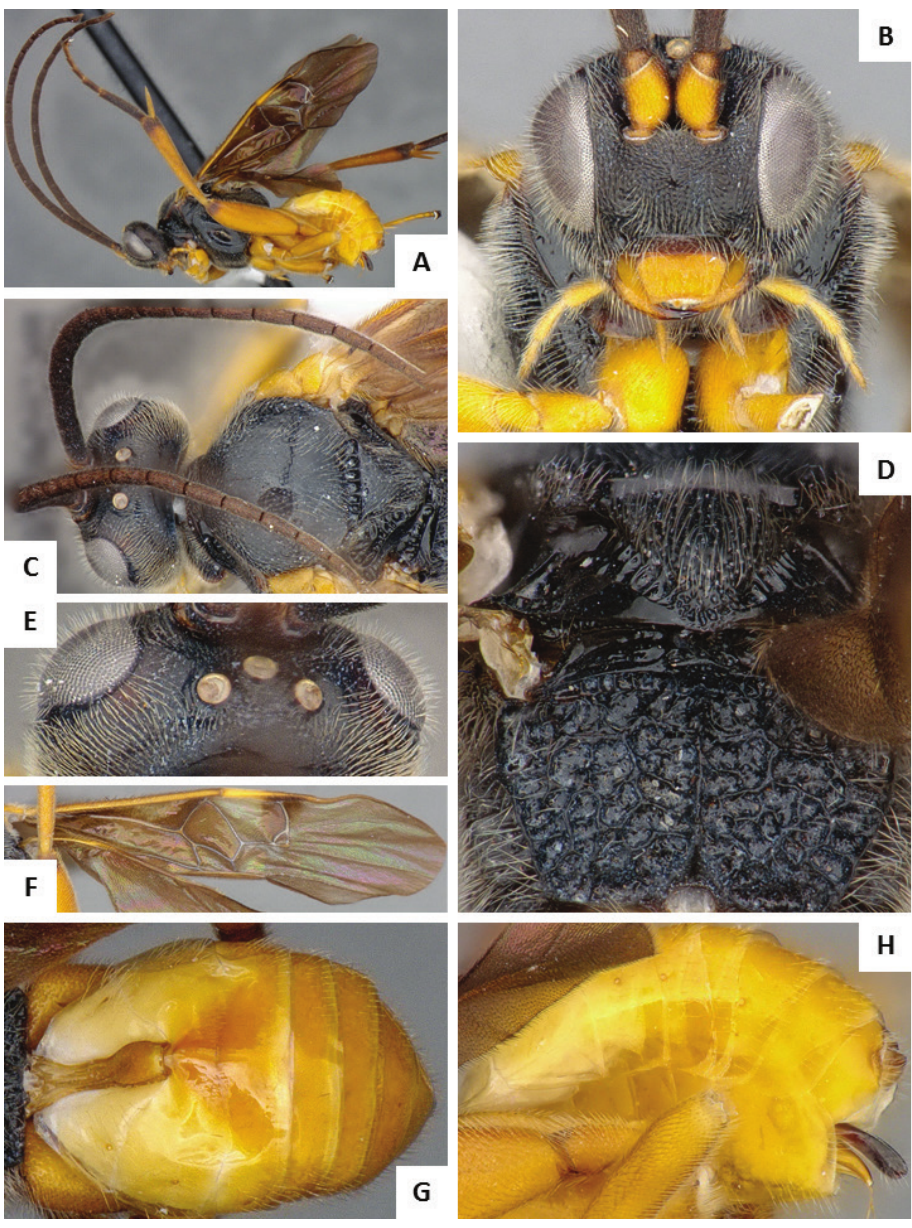
Figure 37. Protomicroplitis calliptera. A Habitus, lateral B Head, frontal C Head and mesosoma (partially), dorsal D Propodeum E Head, dorsal F Wings G Metasoma, dorsal H Metasoma,